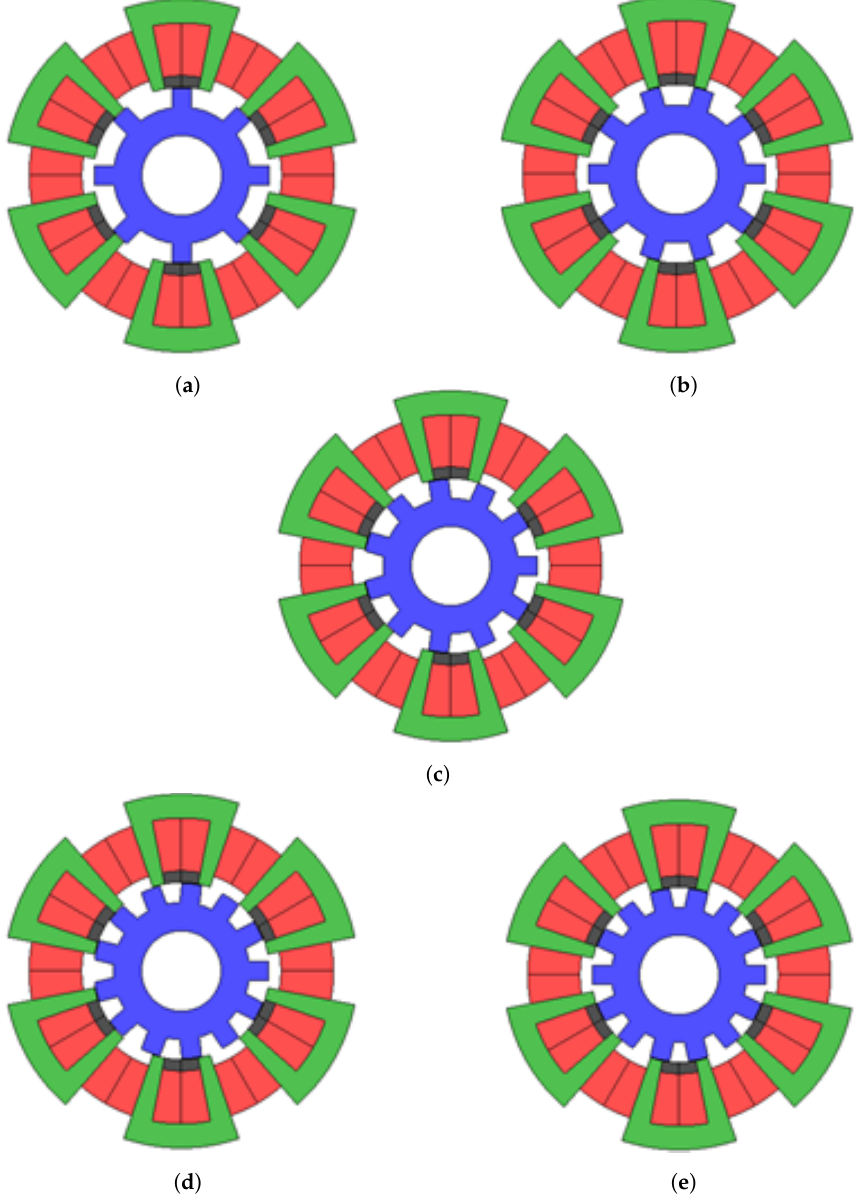
Figure 3. Various rotor poles of a modular stator PM flux reversal machine. ( a ) 8-P/12-S. ( b )